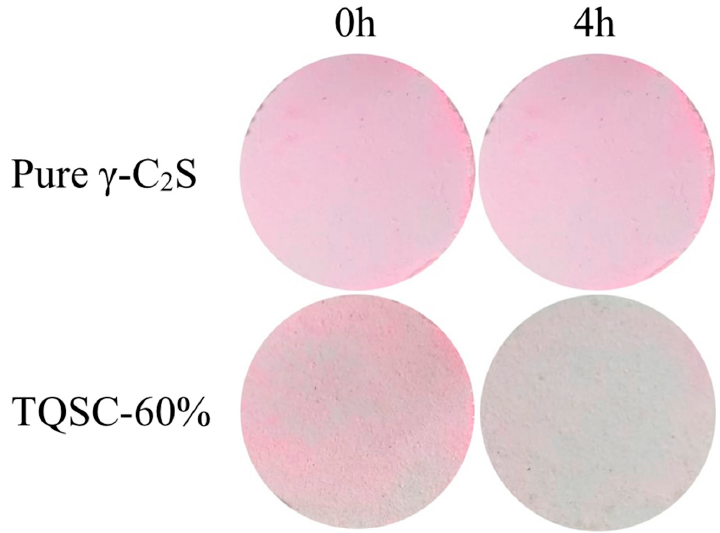
Figure 8. Color variation of RhB coated on pure γ -C 2 S and washed-TQSC-60%.